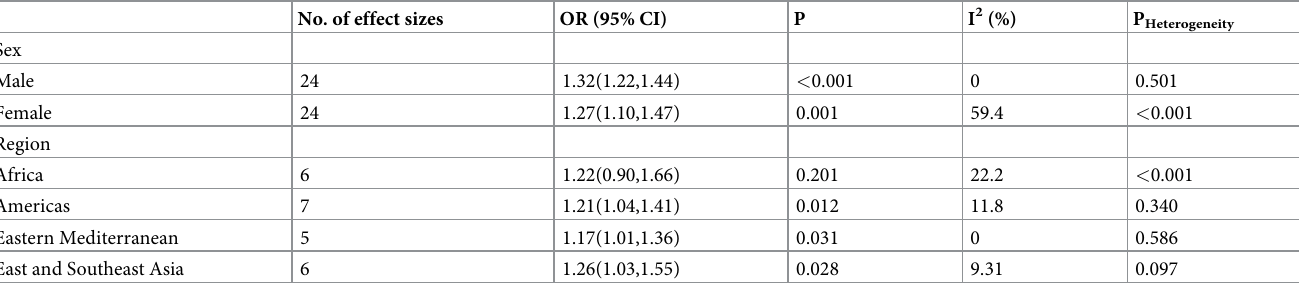
Table 2. Subgroup analysis for > 2 h/d of sedentary behaviour and anxiety symptoms a .